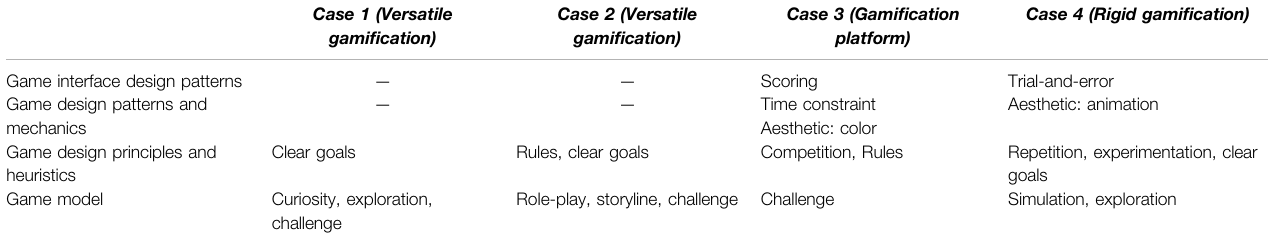
TABLE 2 | Game design breakdown in